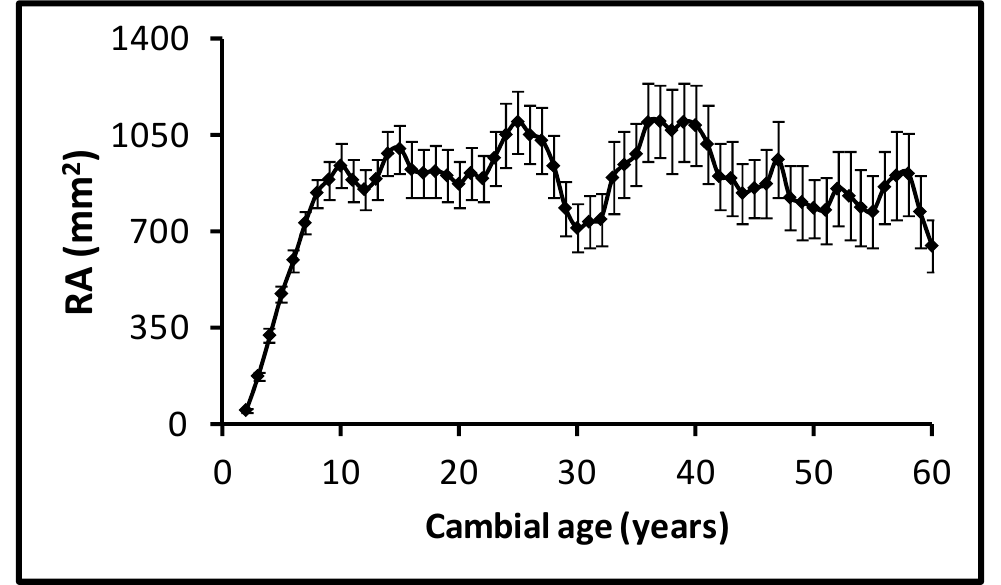
Figure 3. Inter-ring radial variations of the ring area (RA). Bars indicate standard errors of the mean.